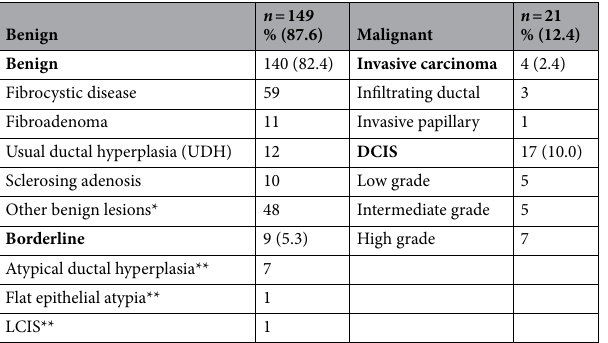
Table 2. HPE findings in 170 VABB lesions. *Other benign lesions include; benign breast tissue, mammary duct ectasia and no malignancy. **Borderline lesions.